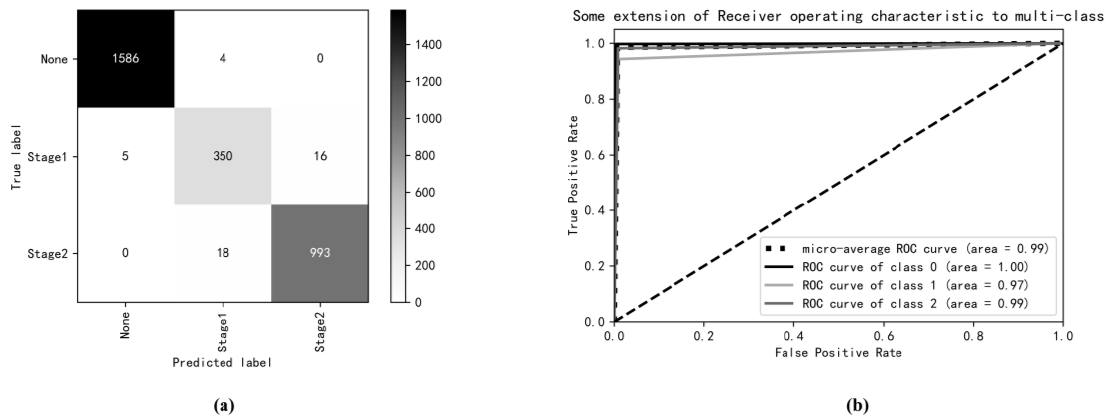
Figure 6. The assessment results of the proposed model expressed in terms of the confusion matrix ( a ) and the ROC curve ( b ).